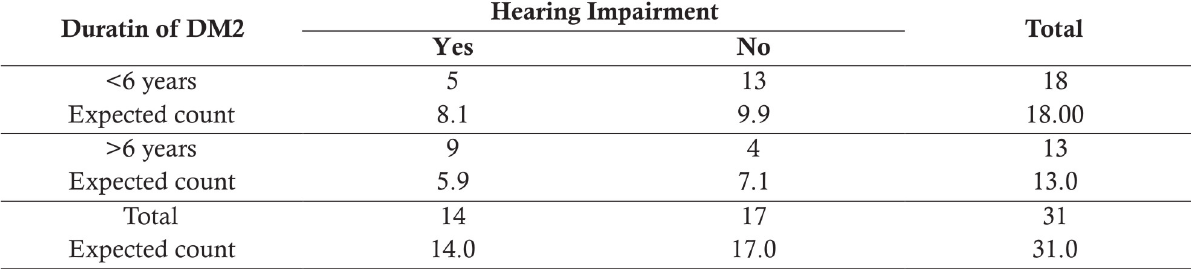
Table . Chi Square Test